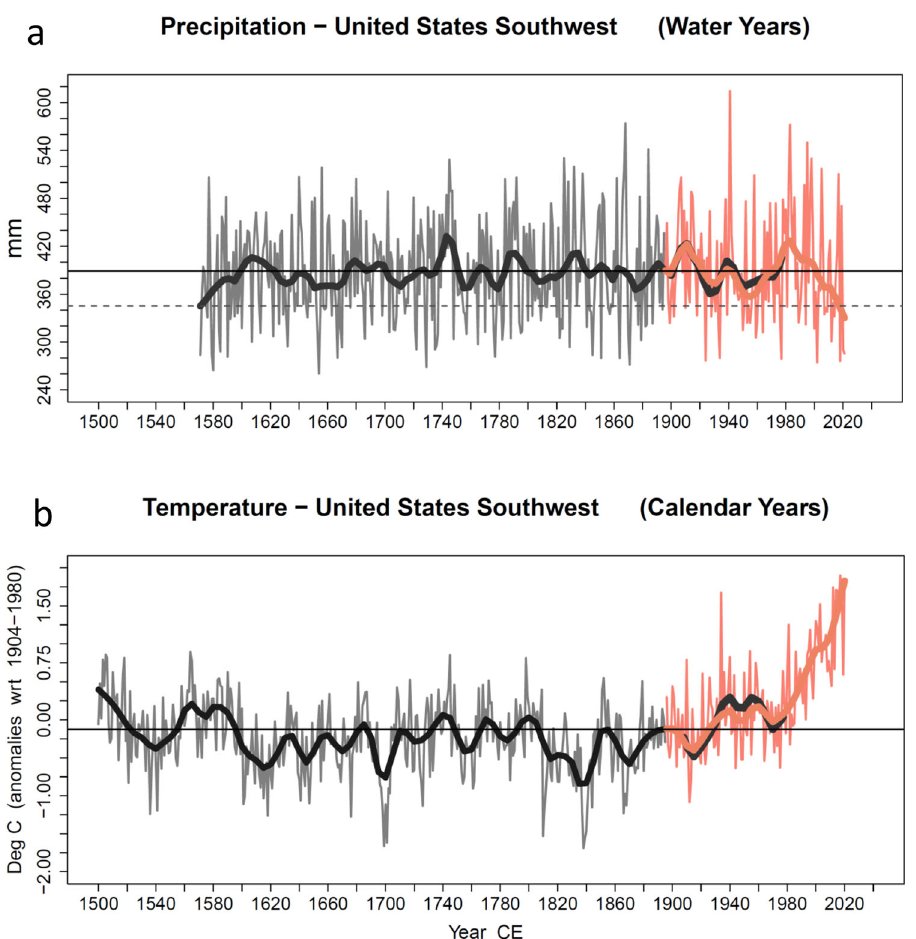
Fig. 1 Southwest historical water year precipitation and calendar year annual mean temperature. Water year (Oct t-1 to Sept t ) precipitation ( a ), 1571- 2021, and calendar year temperature ( b ), 1500-2020, in the SW. Gray and dark gray indicate paleoreconstructions (RECON, through 1895), salmon indicates instrumental (INST, 1896-on) data; heavy lines indicate ~21-year lowess smoothing fi lters. Solid horizontal lines indicate means of full RECON + INST time series; dashed horizontal line (top) indicates smooth value for 1571. Correlations between RECON and INST smooths during period of overlap (to 1977 precipitation, to 1980 temperature) are 0.88 and 0.92,